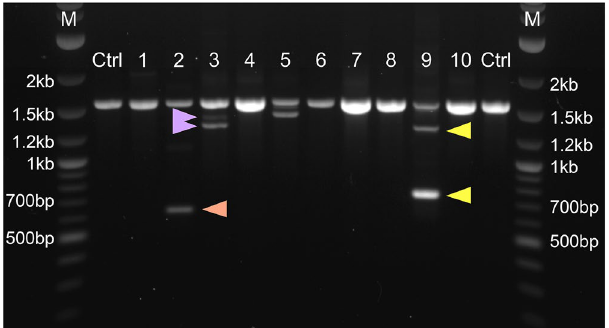
Figure 4. PCR amplification of genomic DNA reveals larger deletions. A 1592 bp region spanning the third exon of the T gene was amplified from genomic DNA of 10 individual CRISPants (numbered 1 through 10) and genomic DNA from unmanipulated mice (Ctrl: control). The orange triangle identifies an amplicon of approximately 650 pb length in sample 2, indicative of a large deletion with an estimated length of 950 bp. Purple arrows point to bands in sample 3 of ~ 1.4 and ~ 1.3 kb size, respectively, indicating putative deletions of ~ 200 and ~ 300 bp size. Yellow arrows mark amplicons in sample 9 of ~ 1.3 kb and ~ 800 bp size, predicting the presence of deletions of ~ 300 bp and ~ 800 bp, respectively. M: Lane of marker DNA fragments of indicated